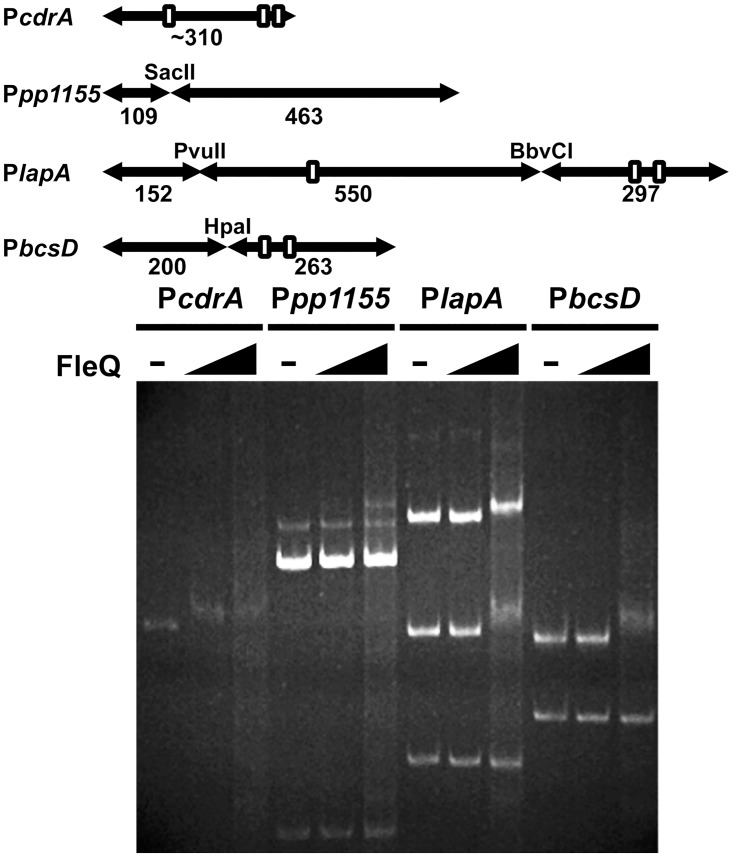
Gel mobility shift assays of FleQ on the PlapA and PbcsD promoters.Top: Cartoon of the probes used for each of the promoter regions, indicating the restriction enzymes used for cleavage, the sizes (in bp) of the resulting fragments, and the location of the predicted FleQ binding motifs (open boxes). Drawn to scale. Bottom: Ethidium bromide-stained PAGE showing the results of a typical gel mobility shift assay. Each promoter region was challenged with 0, 0.45 and 4.5 μM FleQ.